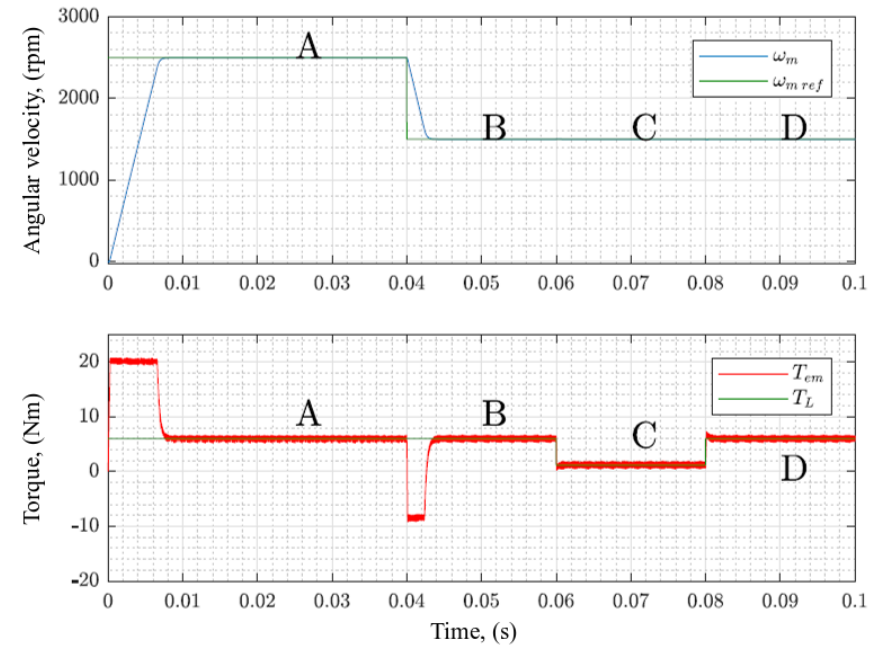
Figure 10. PI control loop, parallel configuration. Transient and steady state responses. Table 6. PI control loop, parallel configuration. Transient and steady state